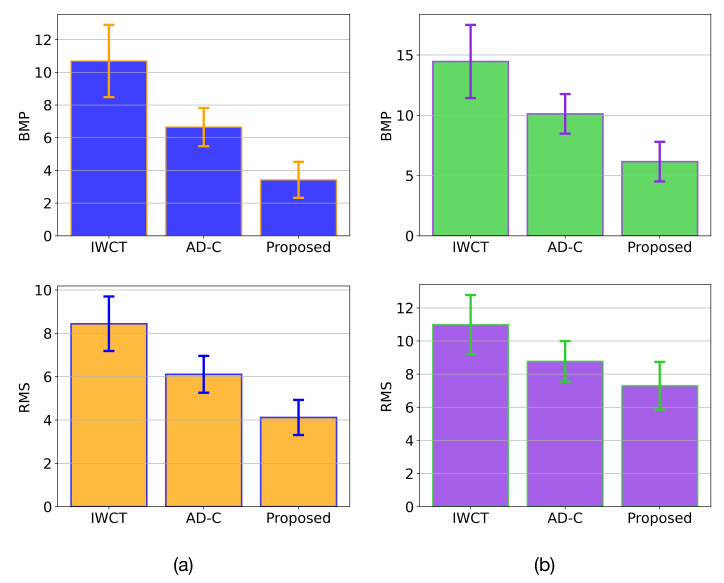
Figure 7. Statistical performance results in terms of BMP and RMS measurements in twenty-five stereo images of the evaluated methods. ( a ) Disparity estimation results in non-occluded image regions. ( b ) Statistical performance of the suggested method of disparity